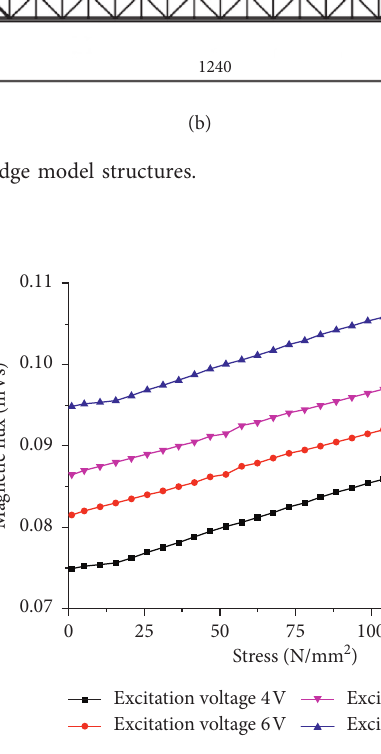
Figure 6: The relationships between stress and magnetic flux of No. 1 hanger